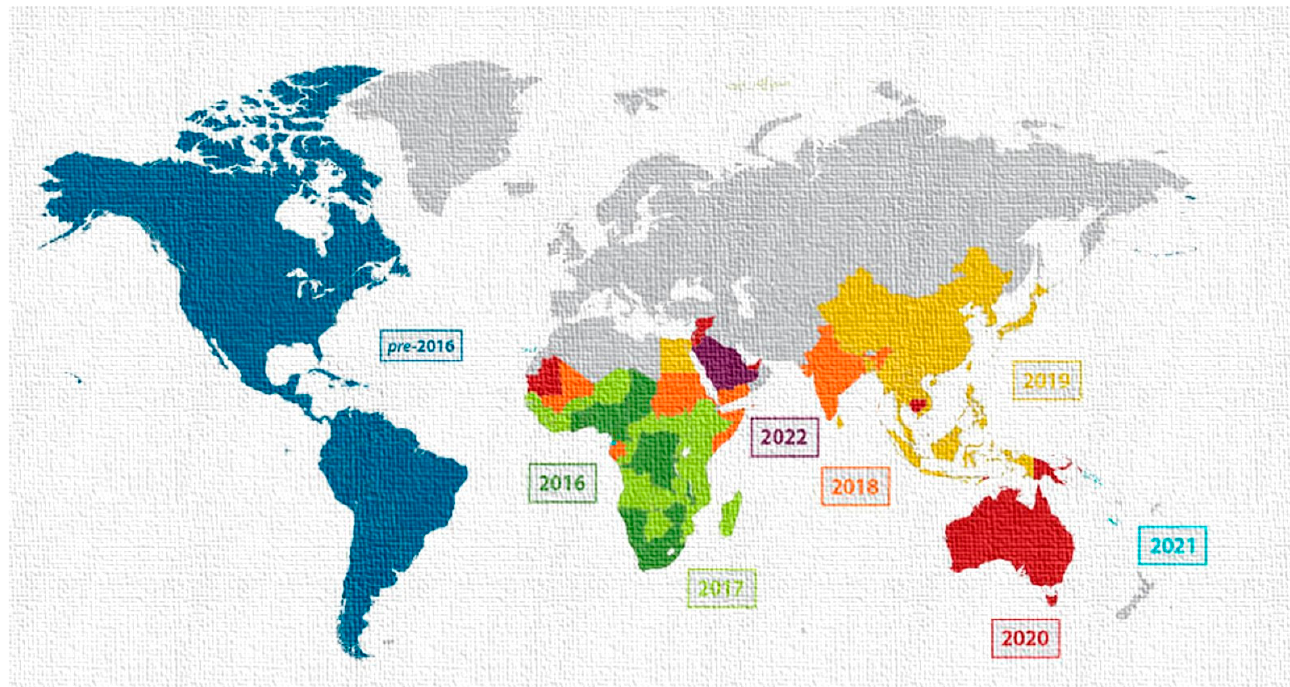
Figure 1. Geographic invasion/expansion of the fall armyworm (FAW), Spodoptera frugiperda, across the world (source from [9]adapted).